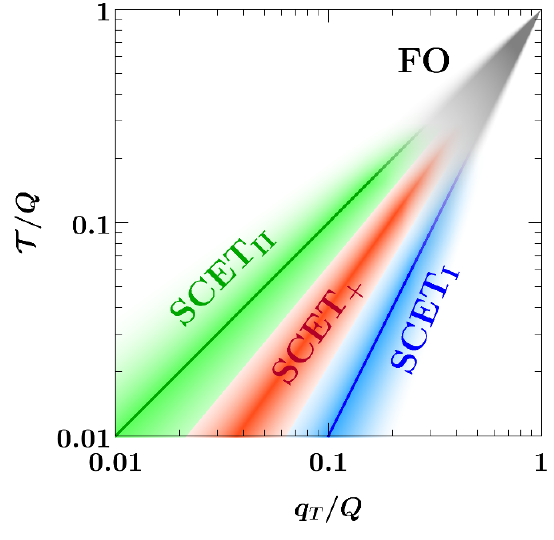
Figure 2 . Parametric regimes in the ( q T ; T ) plane and their SCET description. The solid lines correspond to the phase-space boundaries q T = T (green) and q T =